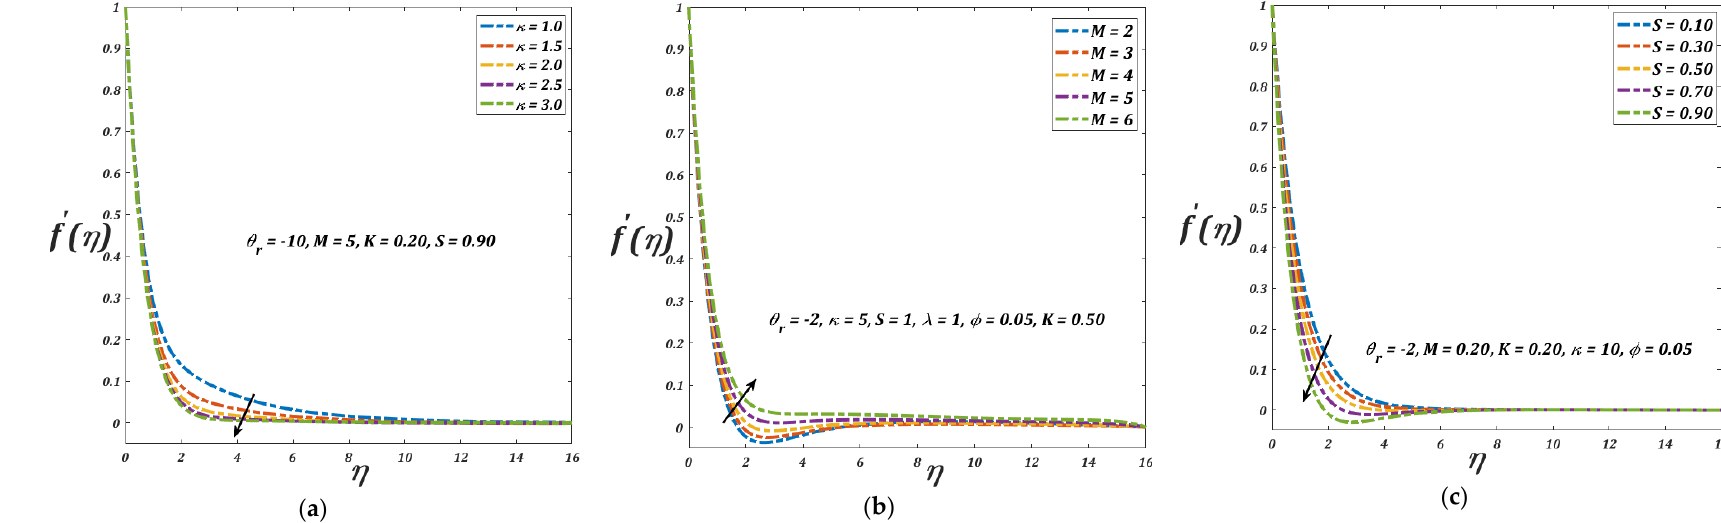
Figure 7. ( a ). Variation in velocity with Curvature parameter. ( b ). Variation in velocity with Magnetic parameter. ( c ). Variation in velocity with Porosity parameter.